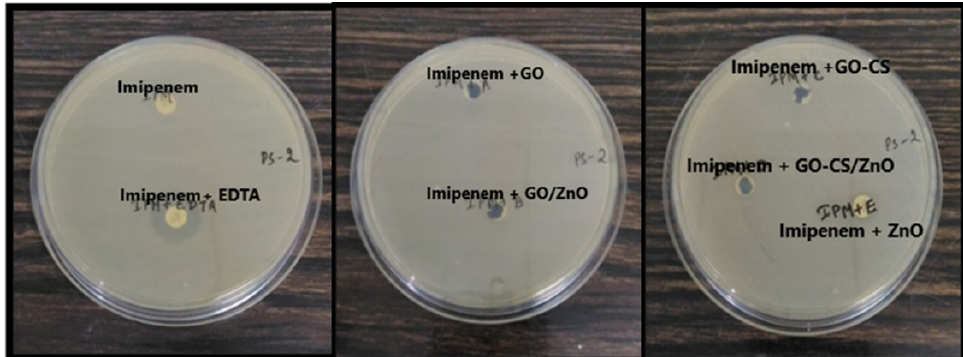
Figure 3. Interaction study of nanomaterials: imipenem and imipenem-EDTA (in mm).